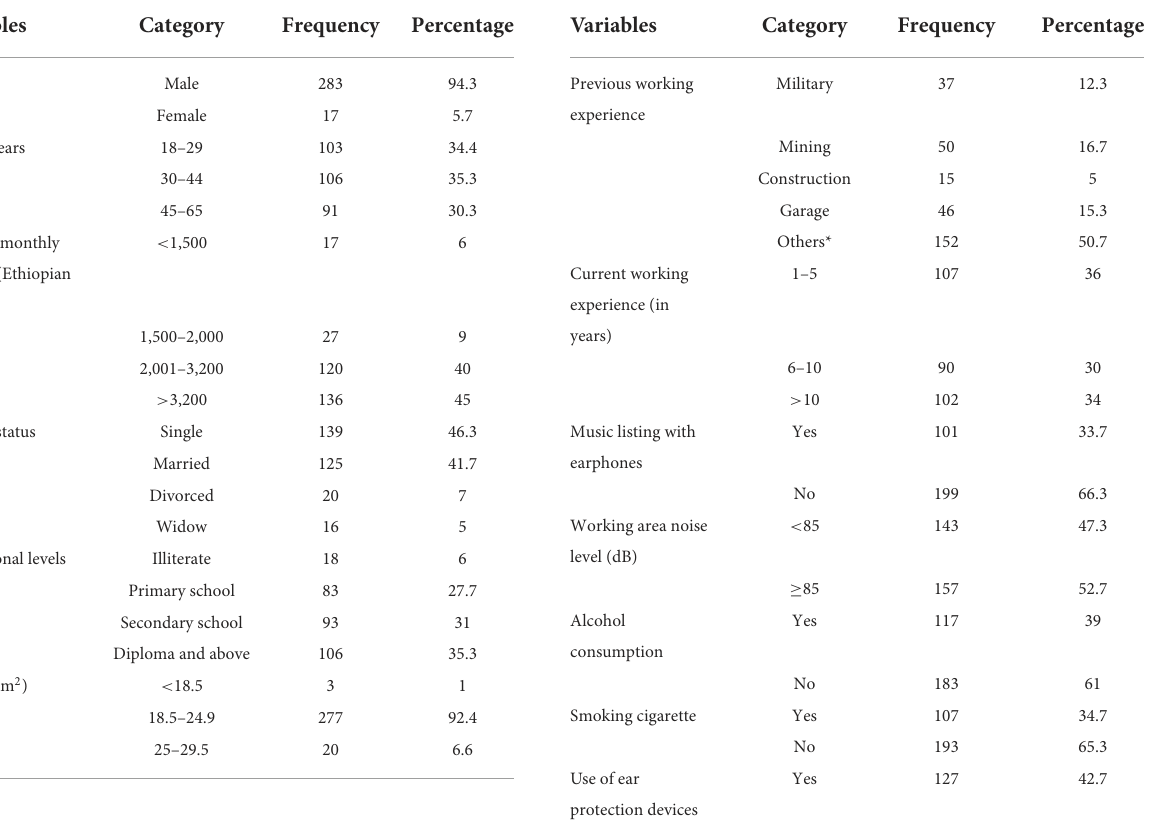
TABLE 1 Socio-demographic and anthropometric characteristics of study participants among metal workers in Gondar city, Northwest Ethiopia, 2021.